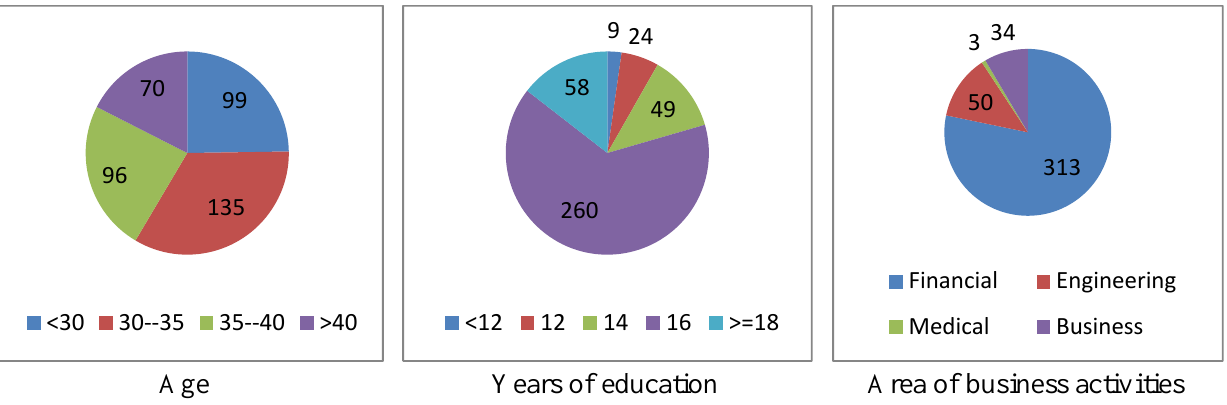
Fig. 1. Personal characteristics of the